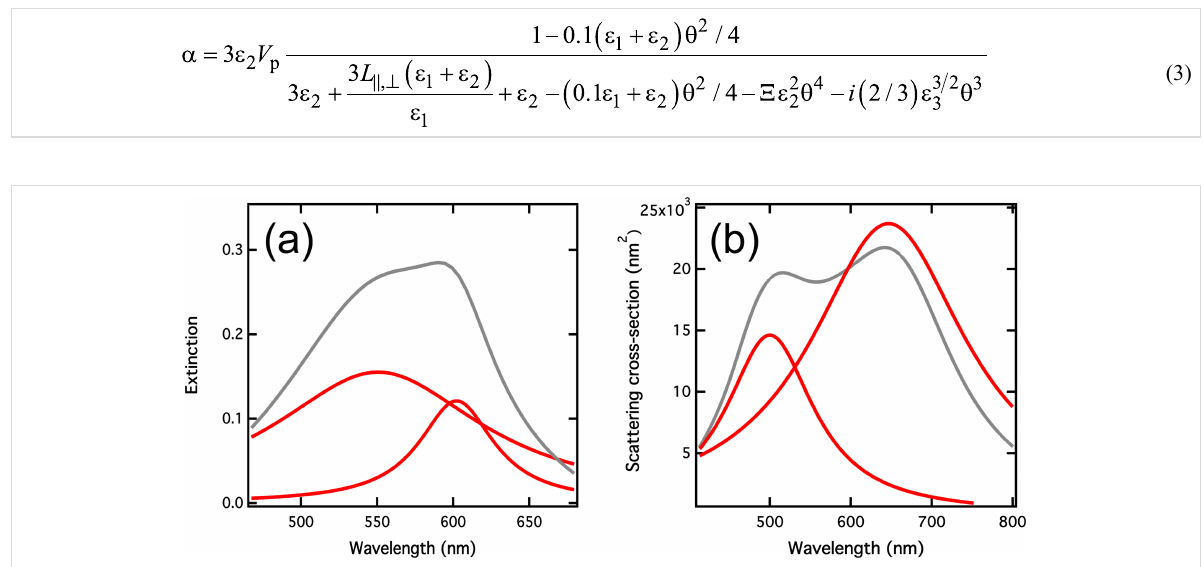
Figure 4: (a) Extinction spectrum (grey curve) recorded with a 70 nm wide and 90 nm long nanorod array covered with the MC isomer. The red curves correspond to the Lorentzian fitted peaks. (b) Extinction cross-section and the fitted peak decomposition, calculated for an ellipsoid of the same